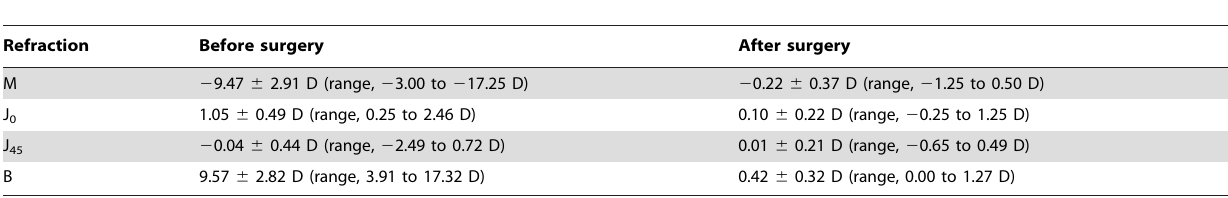
Table 2. Refraction after vectorial conversion before and 3 years after toric implantable collamer lens implantation.